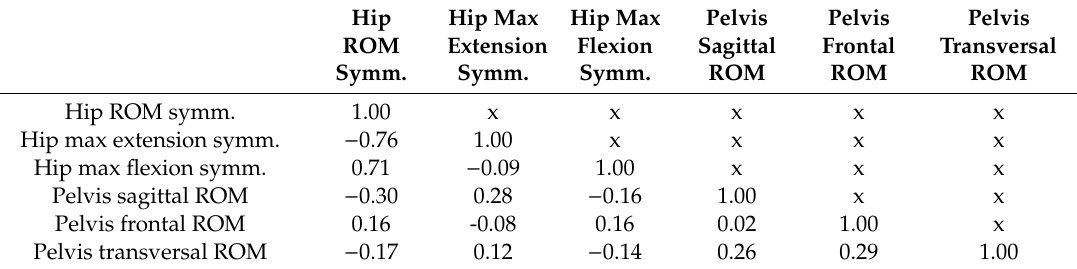
Table 8. Correlation matrix for the features of Set 2. Shown are the values for Stride Time Stride Length Cadence Speed